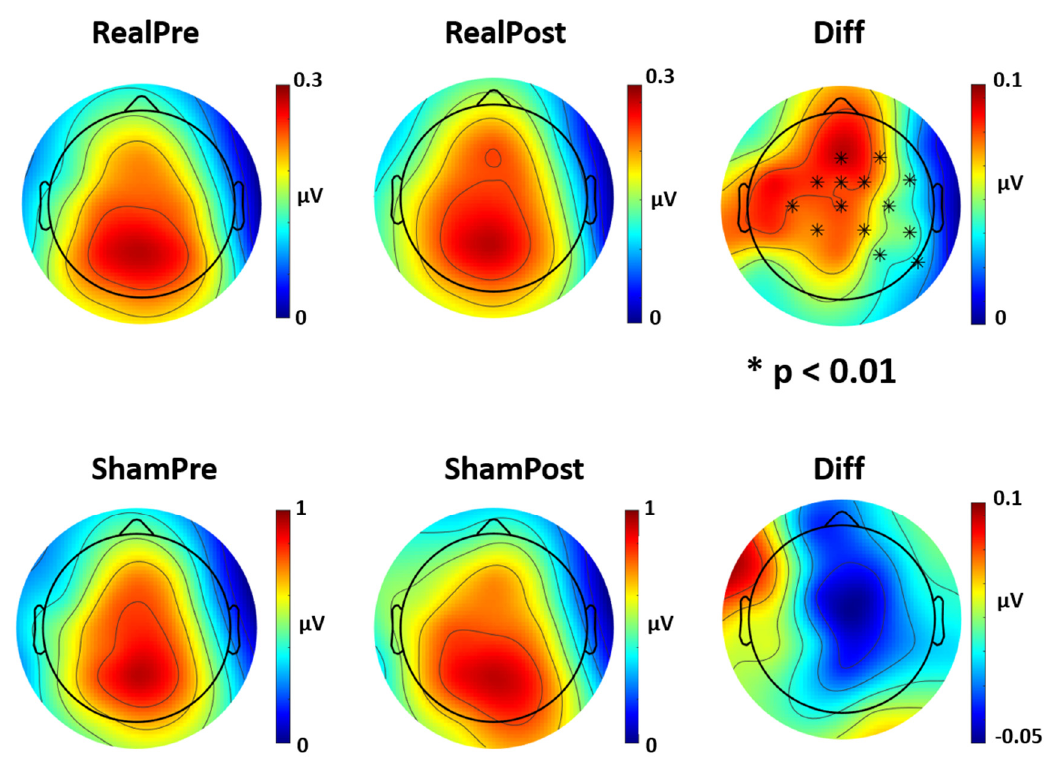
Figure 4. Topoplot of differences in delta power spectrum activity after Real and Sham tVNS stimulation. Delta power spectrum for Real and Sham condition, pre and post stimulation. Real tVNS induced an increase in delta activity across several channels ( p < 0.01), while sham stimulation had no effect on delta activity. Diff = difference in Pre vs. Post stimulation.